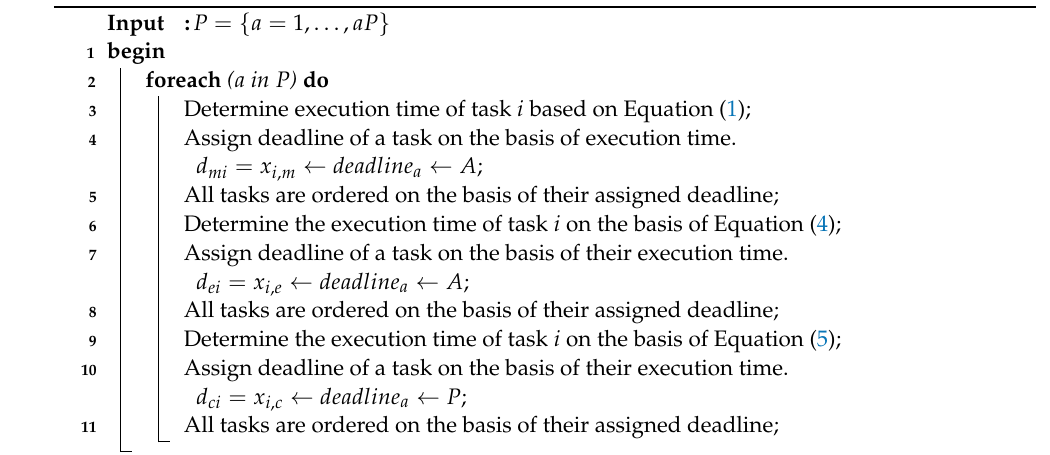
Algorithm 2: Adaptive task sequencing rule scheme.